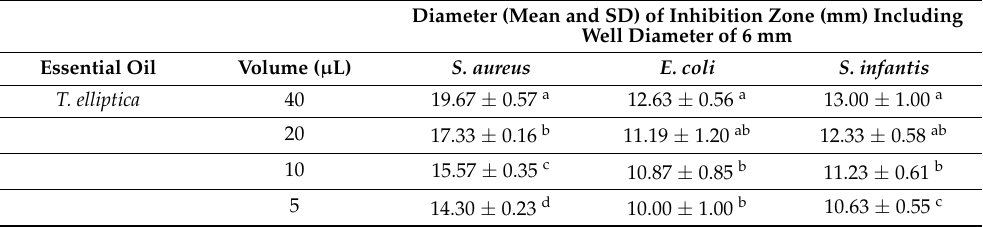
Table 5. Antibacterial activity of T. elliptica essential oil using the agar-well diffusion method. Diameter (Mean and SD) of Inhibition Zone (mm) Including Well Diameter of 6 mm Essential Oil Volume ( µ L) S.